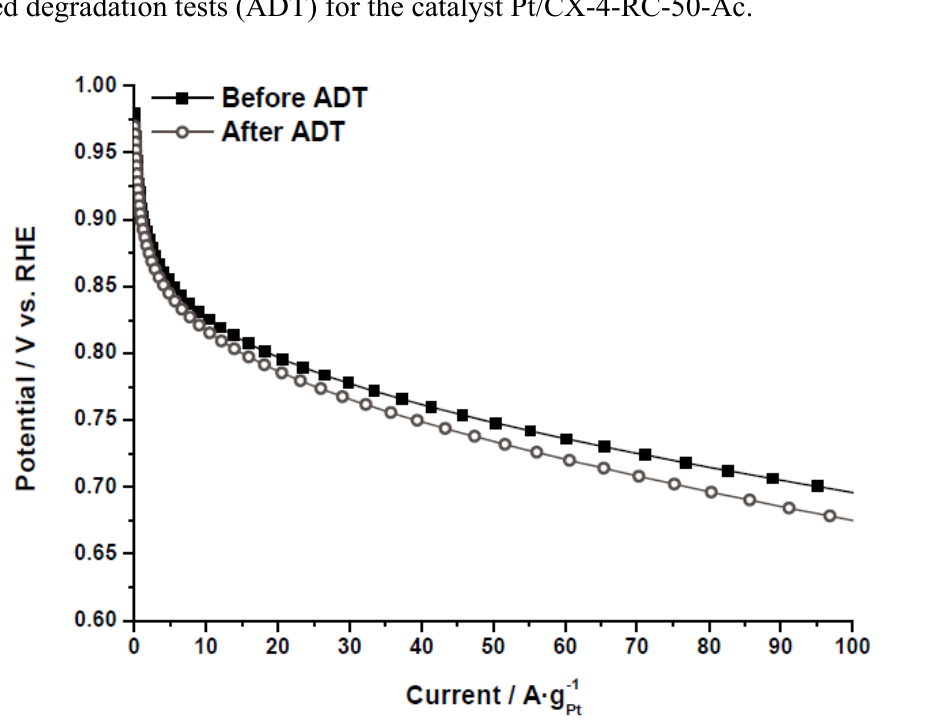
SO , 25 °C) before and after 2 4